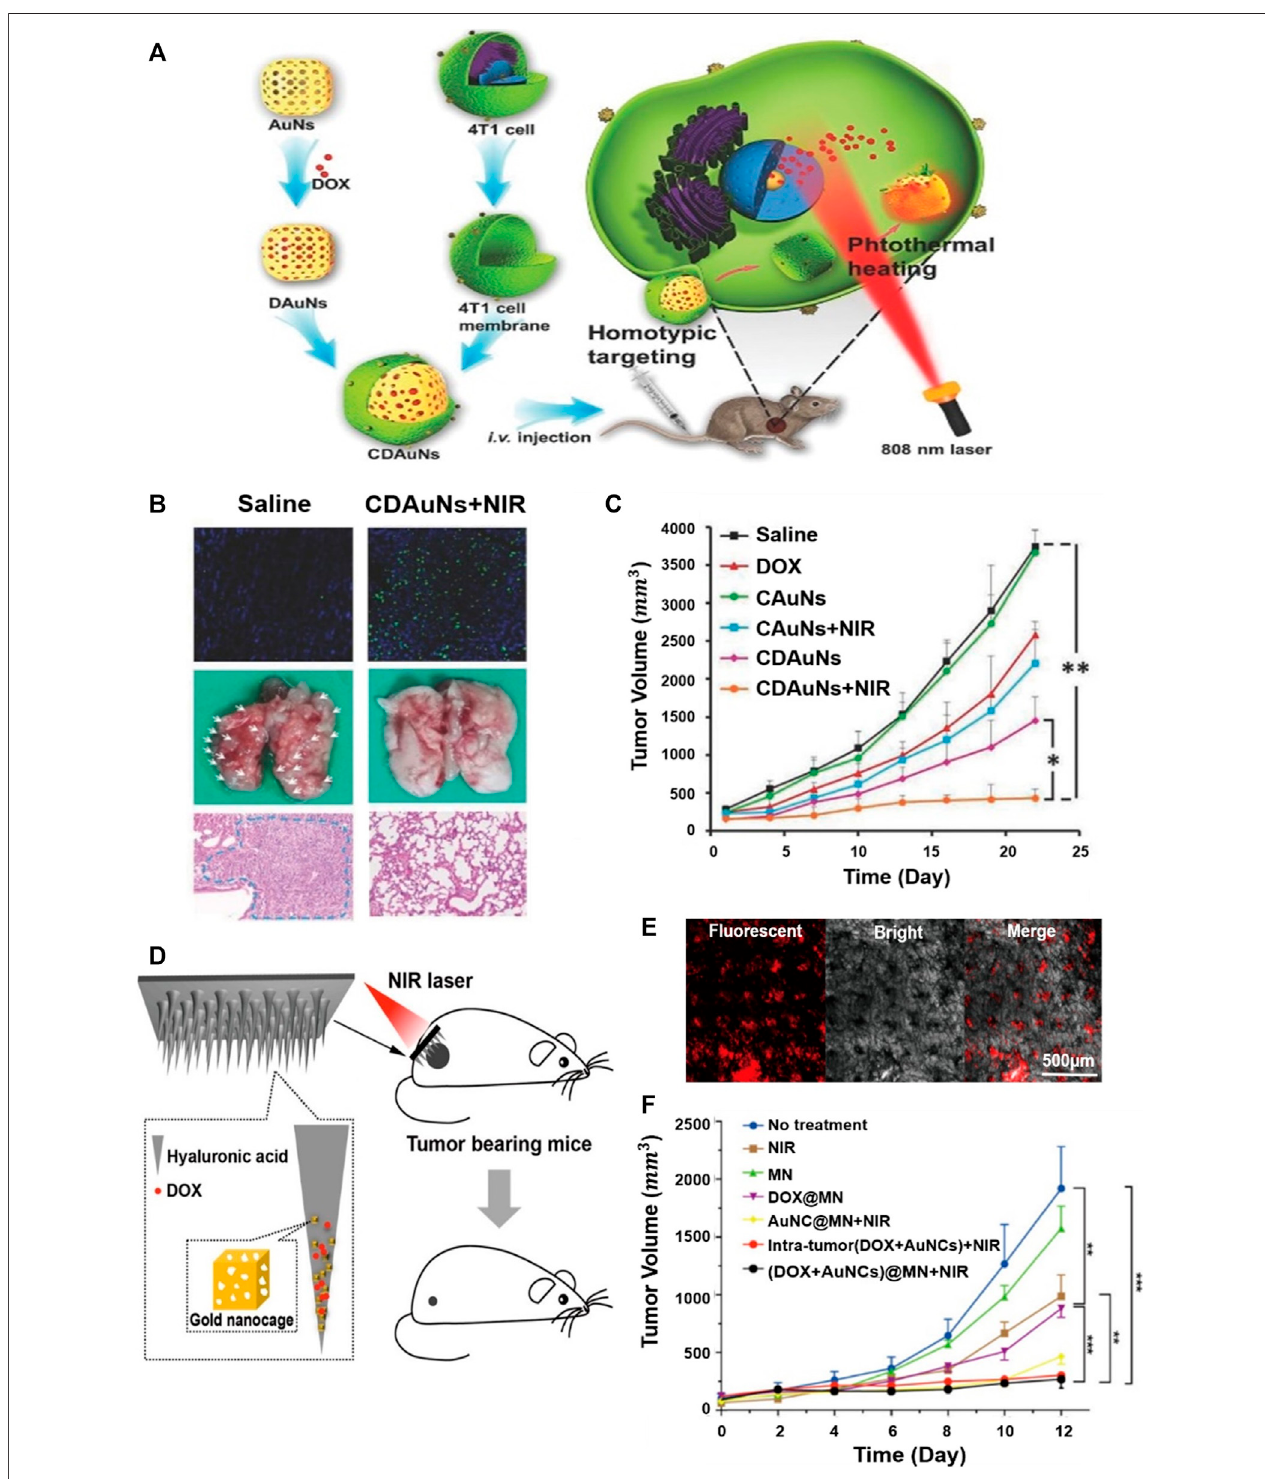
FIGURE 10 | Gold nanocages that suppress high breast cancer metastasis by coating cancer cell membranes. (A) Schematic illustration of the 4T1 cancer cell membrane-coated gold nanocage for thehyperthermia-triggeredrelease ofdoxorubicin (DOX) and homotypic targeted therapy ofbreast tumor growth and metastasis. (B) Terminal deoxynucleotidyl transferase (TdT)-mediated dUTP nick-end labeling (TUNEL) staining (200 × ) of the tumor tissues, the collected lungs, and H&E staining (Scale bar (cid:1) 100 µm) of the lung tissue. White arrows indicate the metastatic models. (C) In vivo antitumor and antimetastasis effects of the nanoparticles in the 4T1 tumor-bearing nude mice of tumor growth pro fi les. Example of applying gold nanocages to microneedles for the local treatment of super fi cial skin tumors. (D)